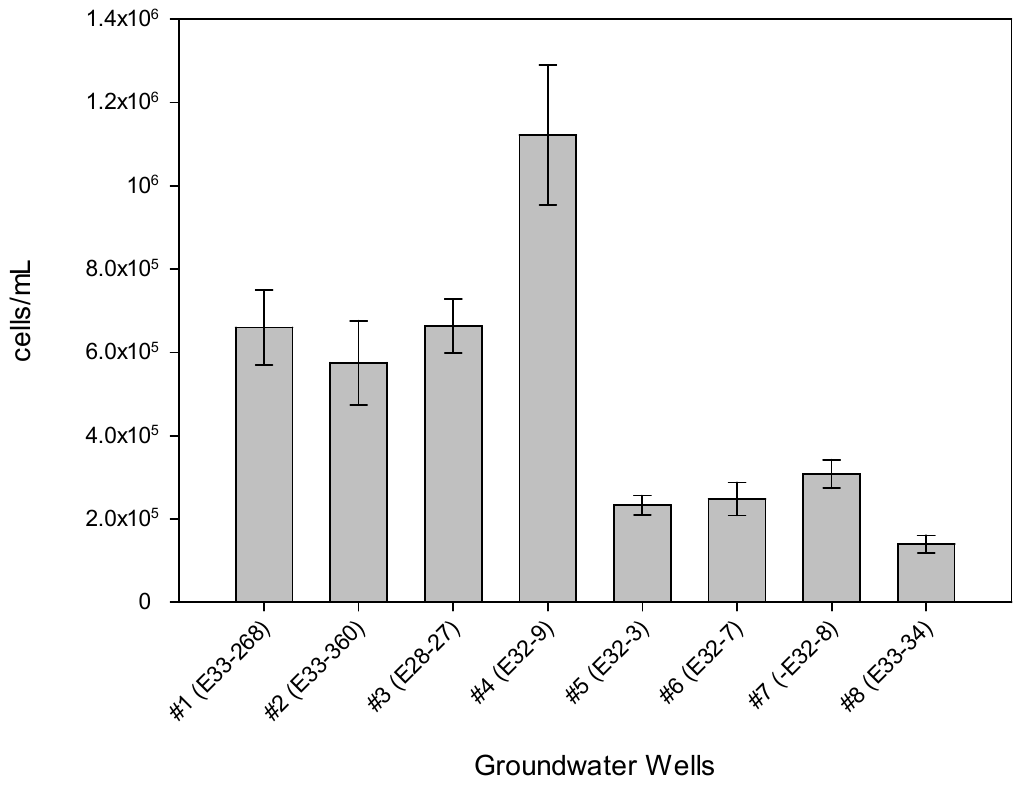
Figure 2. Microbial cell density (cells/mL) in groundwater samples, as determined by DAPI staining and epifluorescence microscopy.